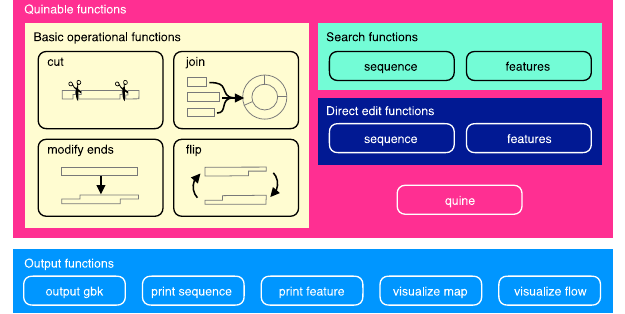
Fig. 2 Overview of QUEEN operational functions.